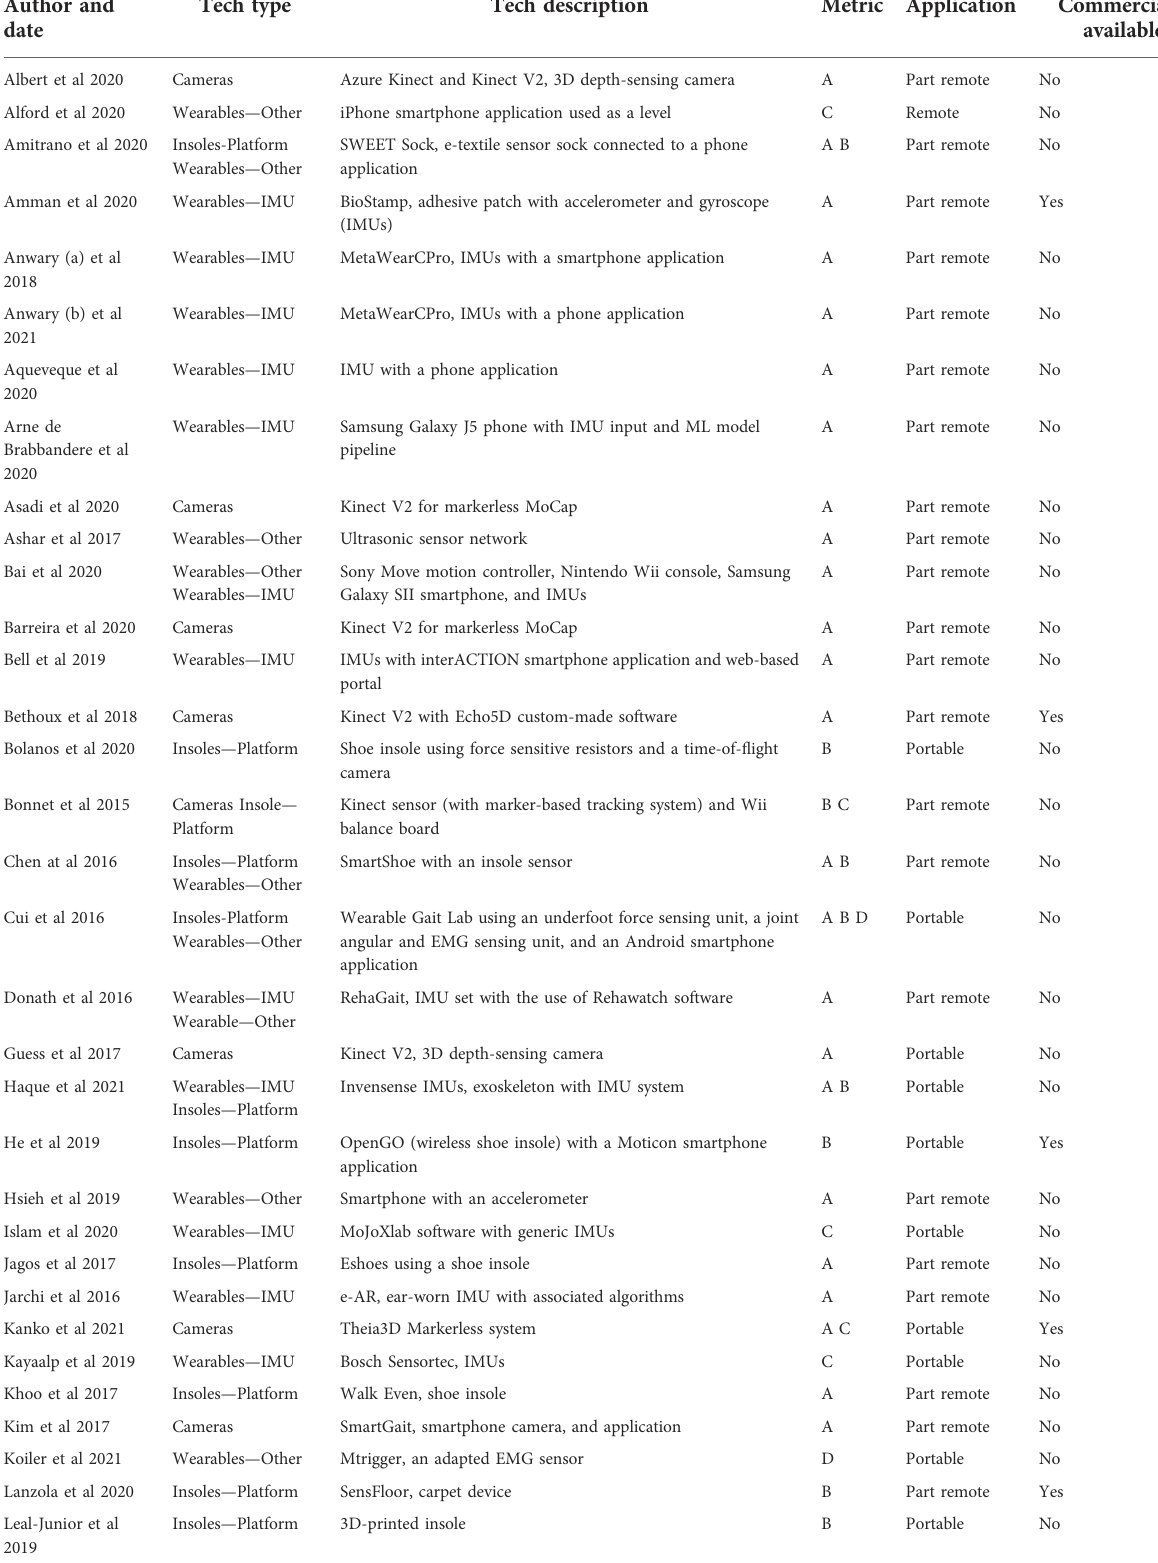
TABLE 3 Master table of technology results divided by type, metric, application, and commercially available